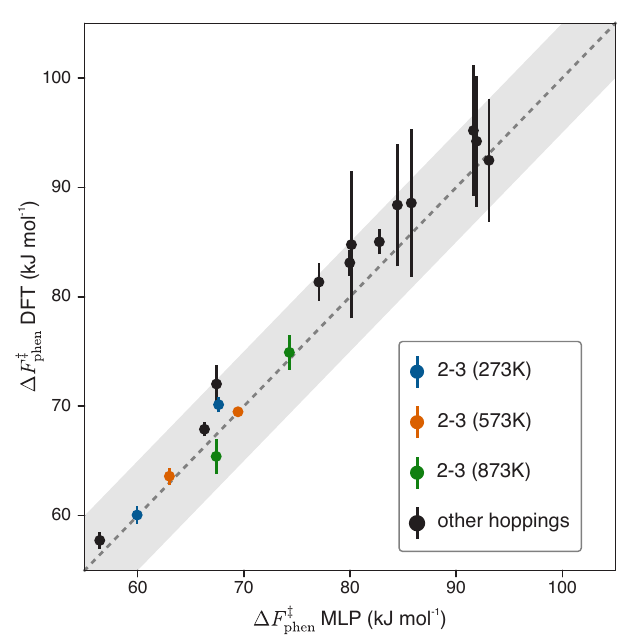
Fig. 4 | The DFT and MLP phenomenological barriers are in excellent agree- ment. The available DFT phenomenological barriers (12 forward and backward barriers for the 873K hoppings, the forward and backward barriers of the 2 – 3 hoppingat573Kandtheforwardandbackwardbarrierofthe1 – 4and2 – 3hoppings at 273K) are all within about ±5kJmol − 1 from the MLP ones, as highlighted by the gray shaded area. The phenomenological barriers of the 2 – 3 hopping at various temperatures,correspondingwiththefreeenergypro fi lesofFig.3,arehighlighted indifferentcolors(273Kinblue,573Kinorangeand873Kingreen).Uncertainties on the MLP barriers are obtained by averaging over three independent runs